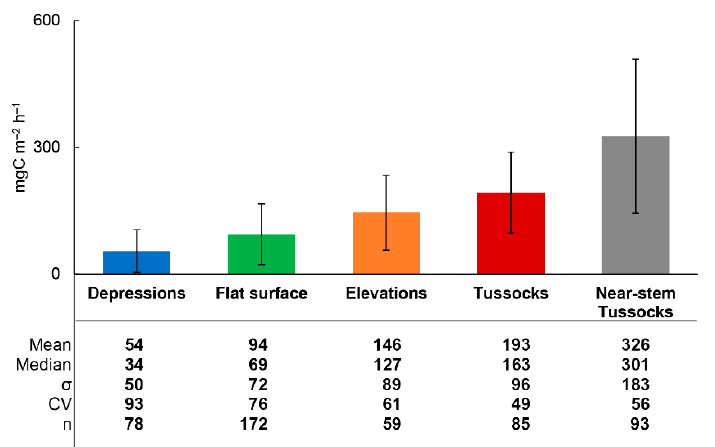
Figure 5. Measured R soil fluxes and their basic statistics at five microsites in alder swamp. Statistic difference between medians of fluxes was checked using the Kruskal–Wallace test: p < 0.05 for all cases except elevation (EL) and tussocks (TUS) microsites where p = 0.11.